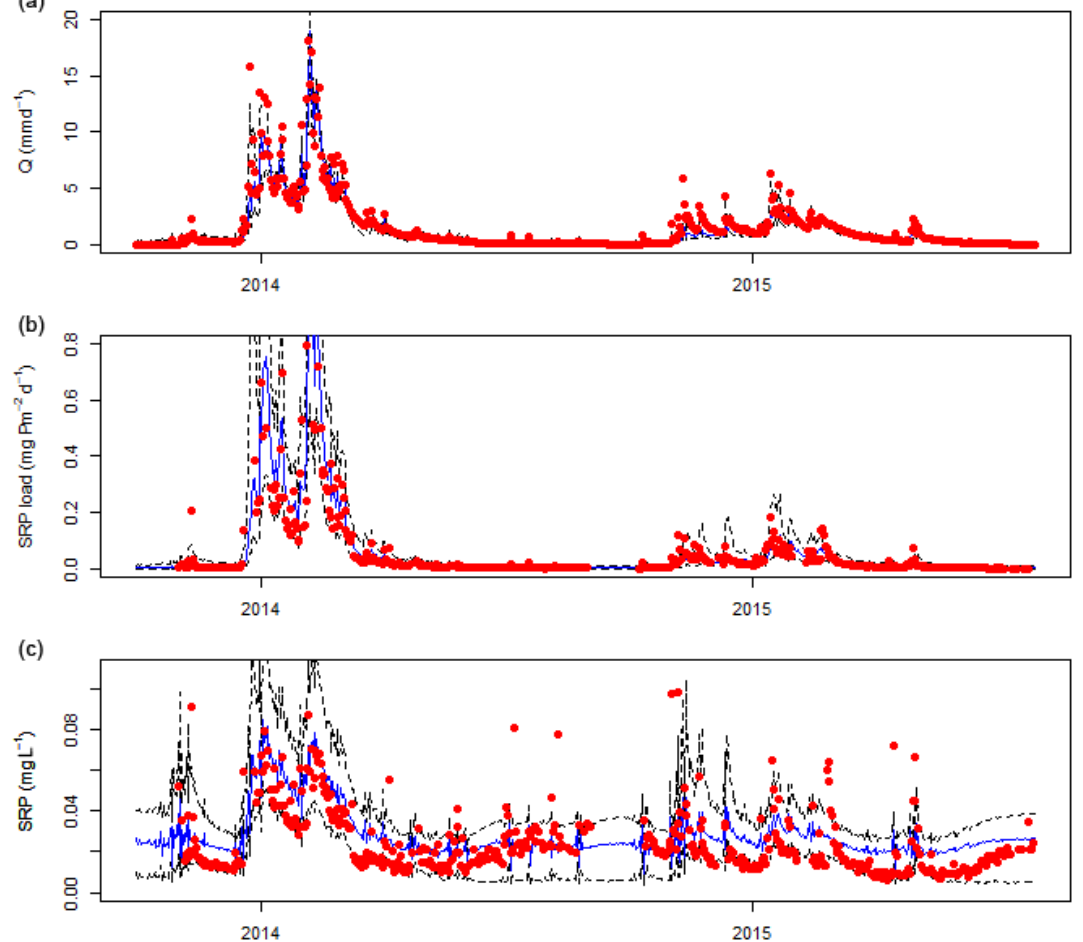
Figure 9. Median and 95% credibility interval for daily discharge (a) , SRP load (b) and SRP concentration (c) . Red circles represent observational